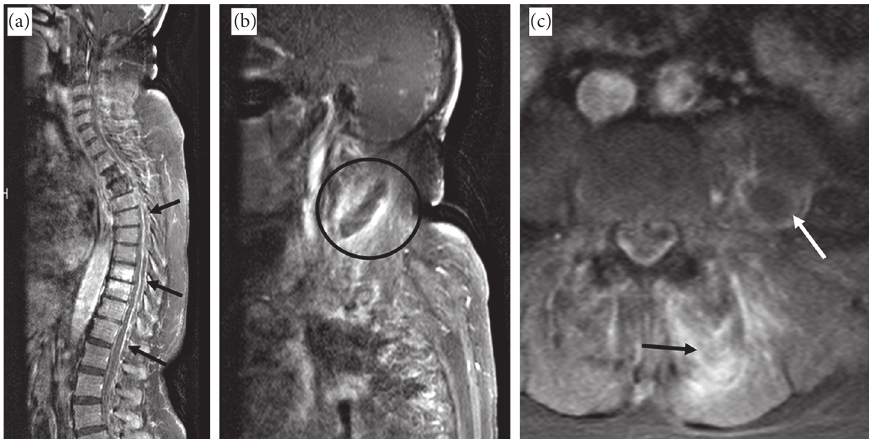
Figure 1: (a) Limited T1 postcontrast whole spine image showing enhancing posterior epidural collection (black arrows) from the level of C3 (not seen in the image) till L1. (b) Sagittal T1 postcontrast views at the cervical level, showing enhancing abscess around the right sternocleidomastoid muscle (black circle). (c) Axial T1 postcontrast images at lumbar levels showing enhancement of the left paraspinal muscles (black arrow) and additional abscess within the left psoas muscle (white